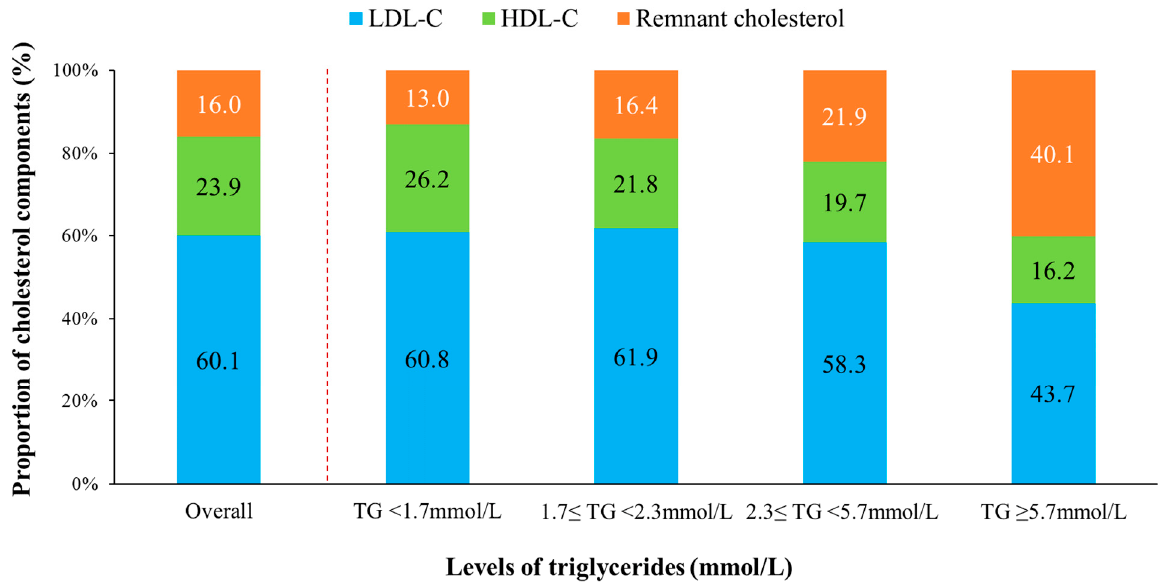
Figure 2. Proportions of different cholesterol components in total cholesterol among the whole patients and in subgroups with different triglyceride concentrations. LDL-C, low-density lipoprotein cholesterol; non-HDL-C, non-high-density lipoprotein cholesterol; TG, triglyceride.